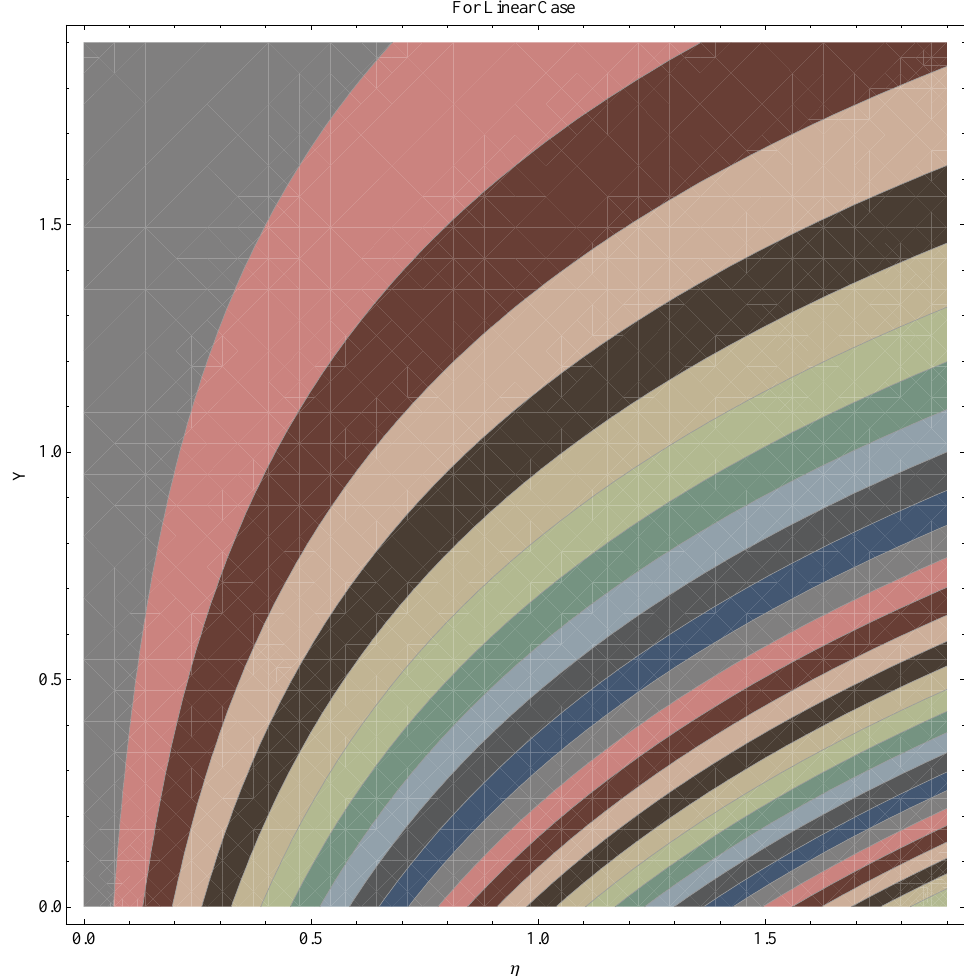
Figure 13. Contour graph for linear